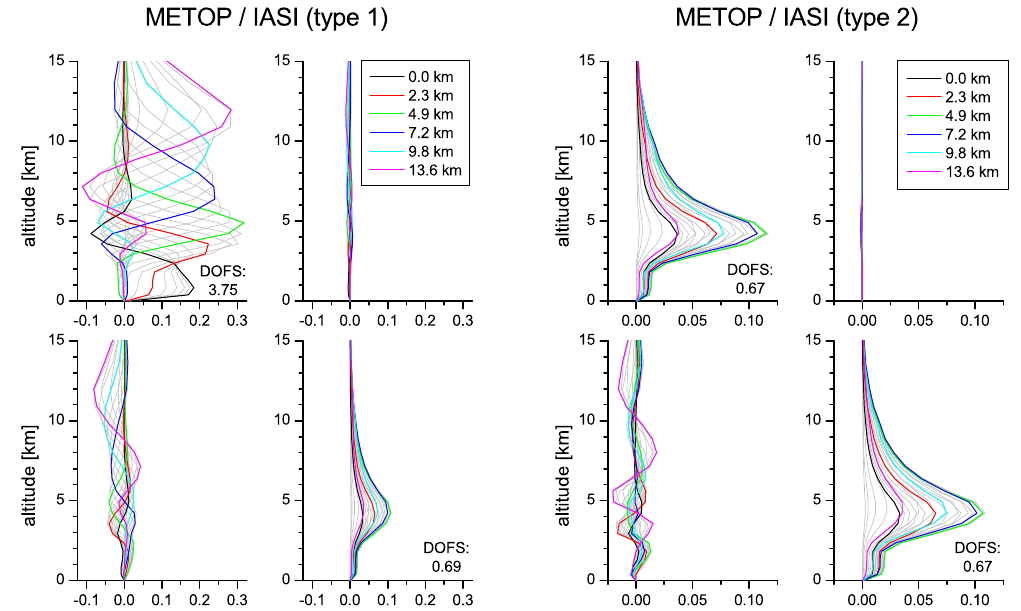
Figure 4. As Fig. 3, but for the { H 2 O, δ D } -proxy states as retrieved from METOP/IASI spectra measured over the subtropical ocean. Please note the different scales in the x axis for the type 1 and type 2 kernels. For more details on the METOP/IASI proxy state kernels see Schneider et al. (2012) and Wiegele et al.